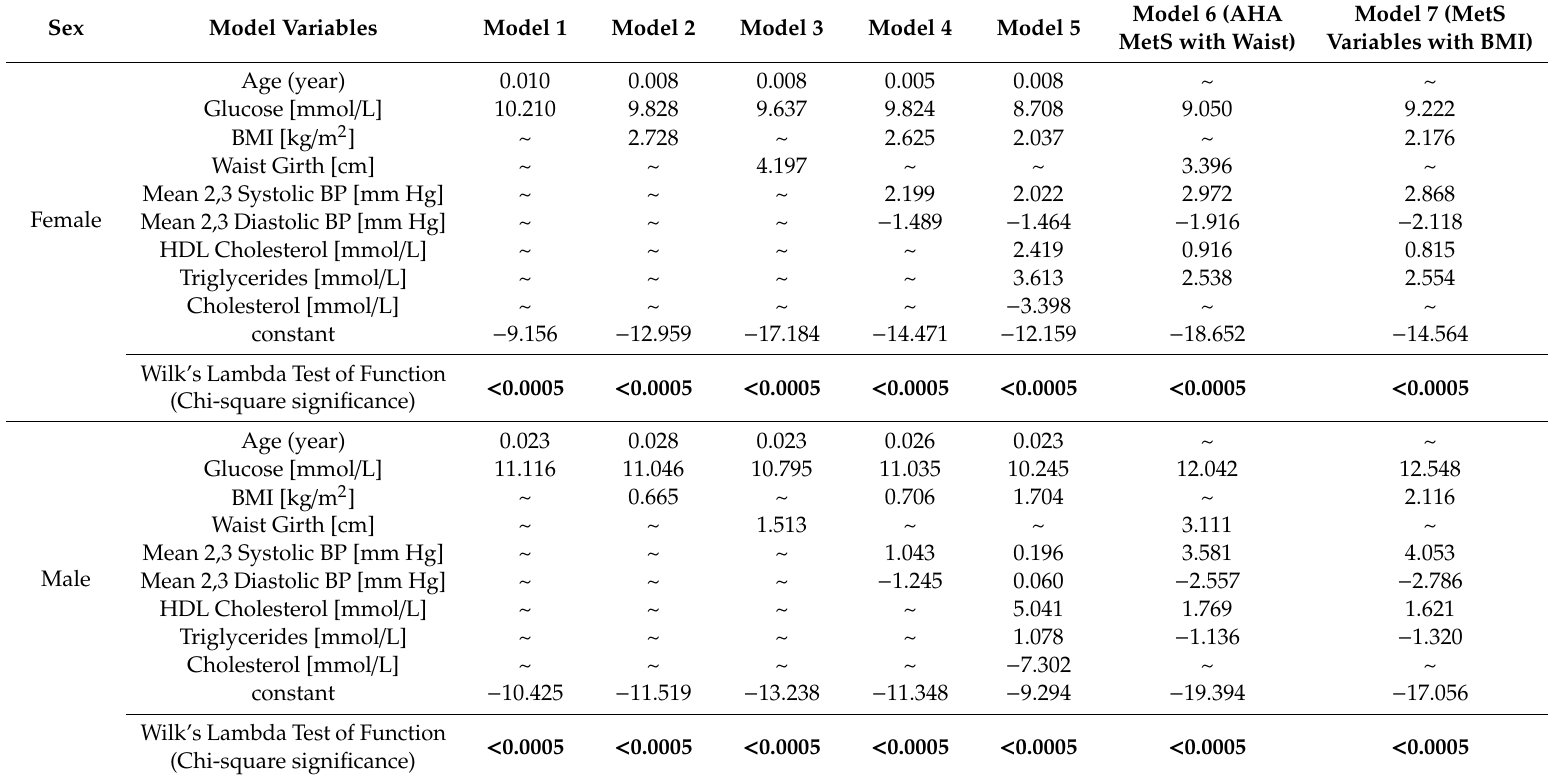
Table 3. Canonical Discriminant Function Coe ffi cients